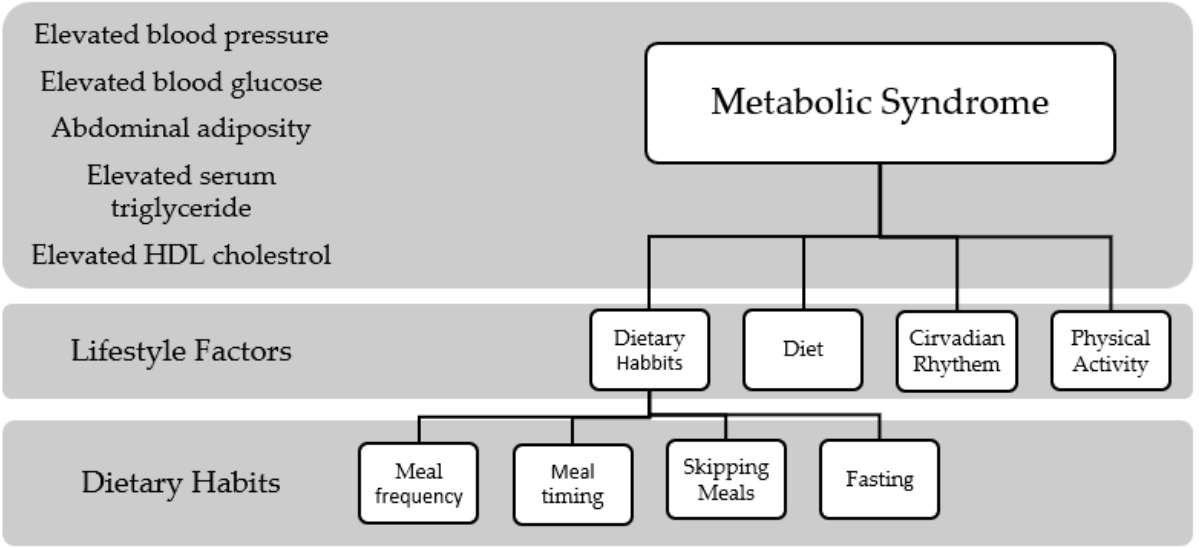
Figure 1. The relationship between Metabolic Syndrome and Lifestyle Factors.